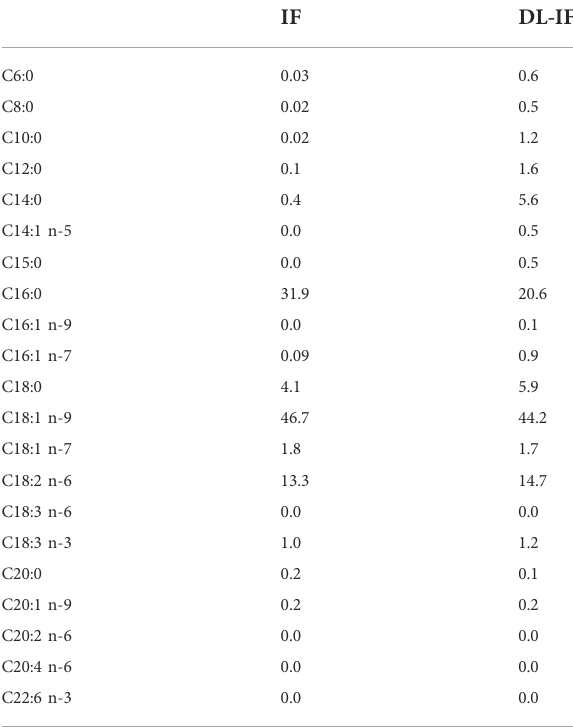
TABLE1Fattyacidcomposition(%oftotalfattyacid)ofinfantformula (IF) and infant formula formulated with dairy lipids